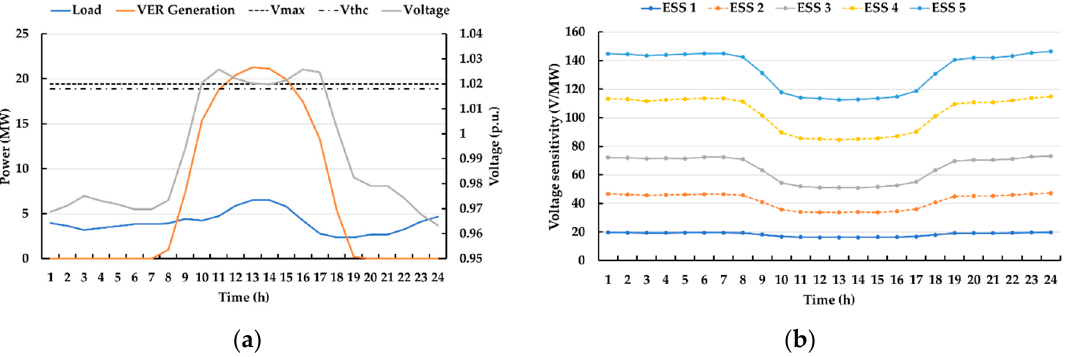
Figure 12. Daily data with the highest generation of VER: ( a ) Load demand, VER generation, and voltage; ( b ) Voltage sensitivity.